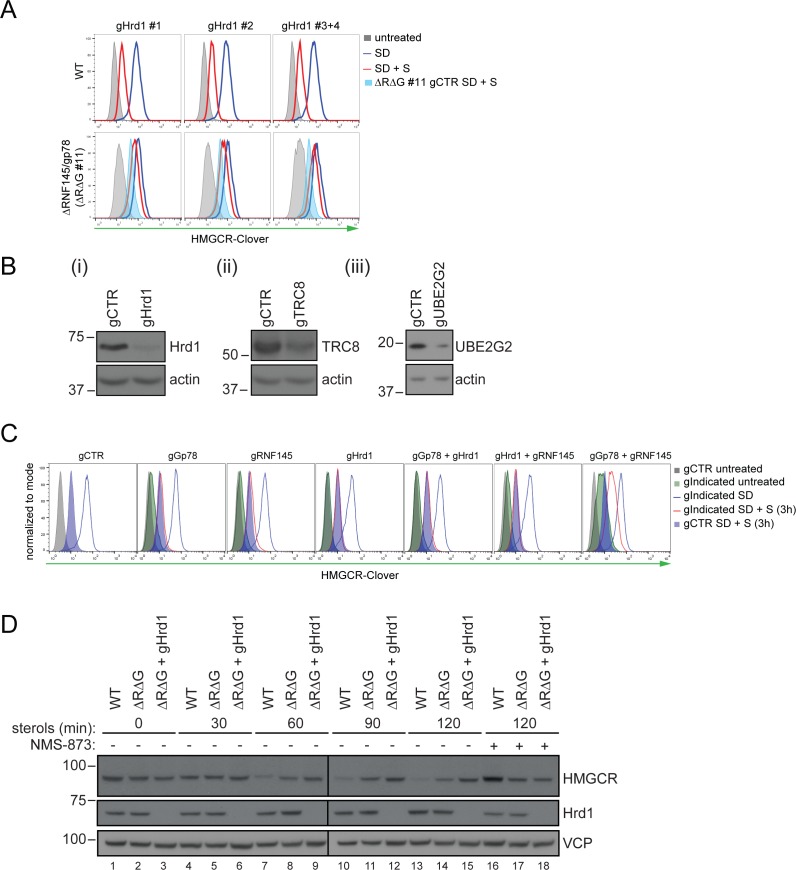
Combinatorial depletion of E3 ubiquitin ligases.(A) WT or RNF145/gp78 knockout (∆R∆G #11) HeLa HMGCR-Clover cells transiently transfected with B2M-specific (gCTR) or Hrd1-specific (gHrd1 #1–4) sgRNAs were sterol-starved (SD, 20 hr) ± sterols (S, 2 hr). HMGCR-Clover expression was detected by FACS analysis. Cells transfected with gCTR are from the same experiment shown in Figure 7B and histograms (gCTR SD +S) were therefore re-plotted. (B) Validation of Hrd1 (i), TRC8 (ii), and UBE2G2 (iii) depletion in ∆R∆G #11 cells. Cell lines used in Figure 7B and Figure 7—figure supplement 1A were collected at steady-state and indicated proteins detected from whole-cell lysate by immunoblotting. A sgRNA targeting B2M (gCTR) served as a control. (C) WT HMGCR-Clover cells transfected with indicated sgRNA pools were sterol-depleted (SD) overnight ± sterols (S, 3 hr). Reporter expression was measured by FACS. (D) WT and ∆R∆G #7 HeLa cells transfected with gCTR (designated ∆R∆G) or a pool of four Hrd1-specific sgRNAs (∆R∆G + gHrd1) were sterol-depleted (20 hr) before addition of sterols for the indicated times ± NMS-873 (10 µM). Validation of RNF145 (∆RNF145 #1) and gp78 knockout clones (∆R∆G #7) can be found in Figure 3—figure supplements 1A and 3B, respectively.